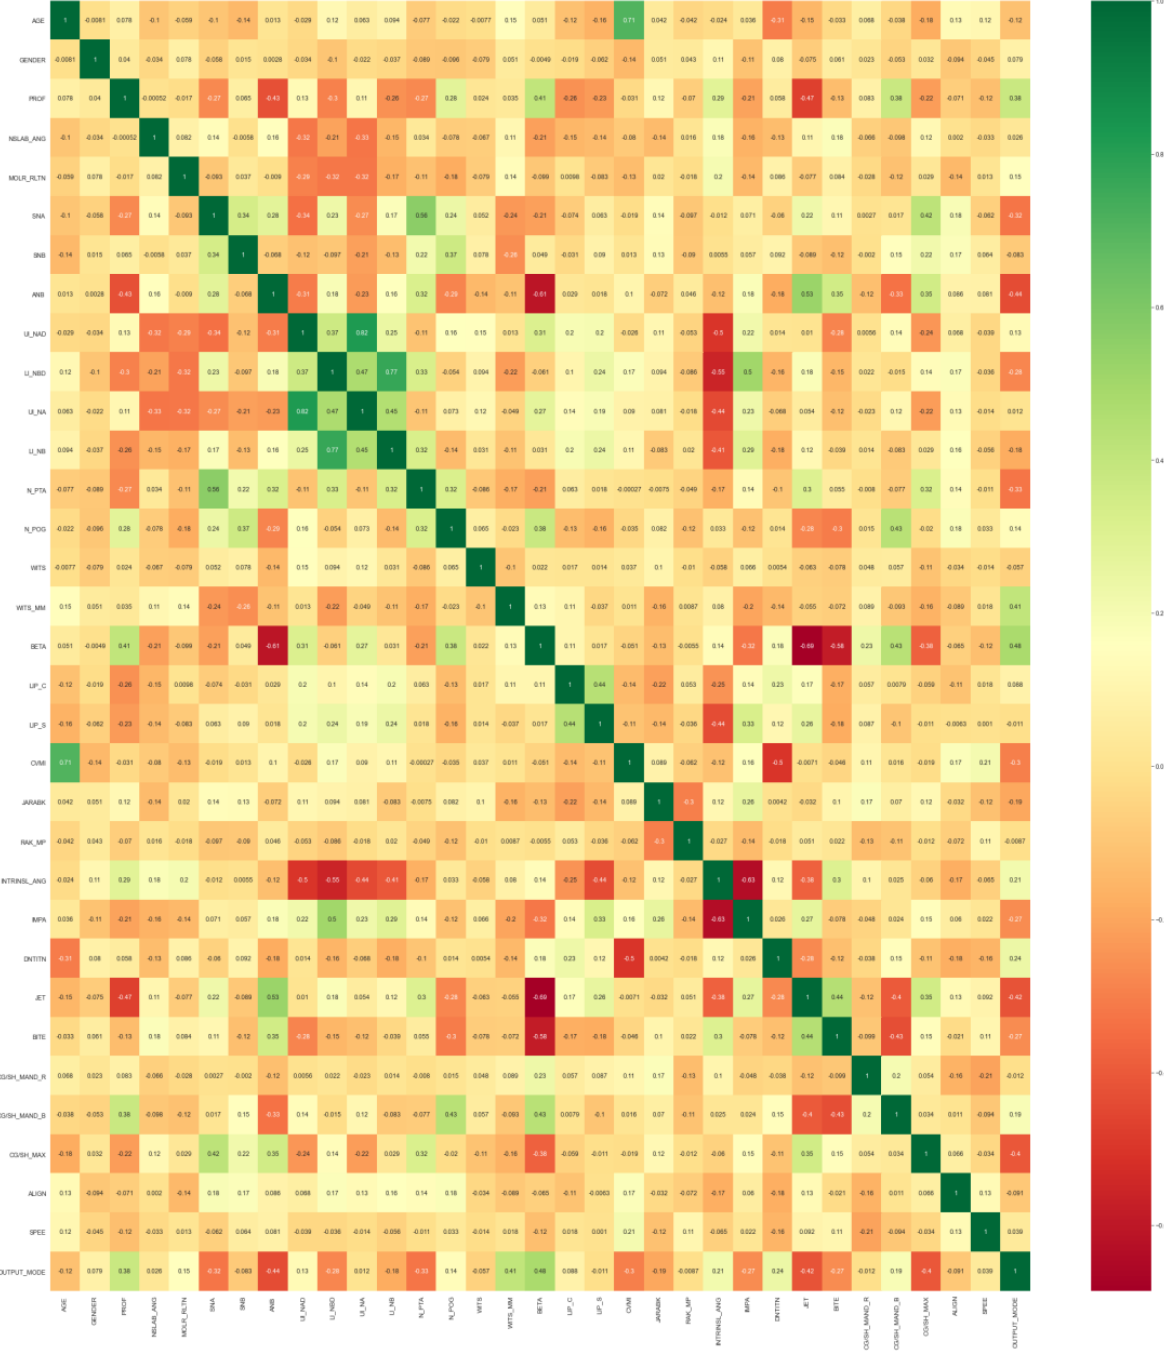
Figure 10. Heat map for correlation between two parameters (greens represent the highest and reds represent the least correlation).